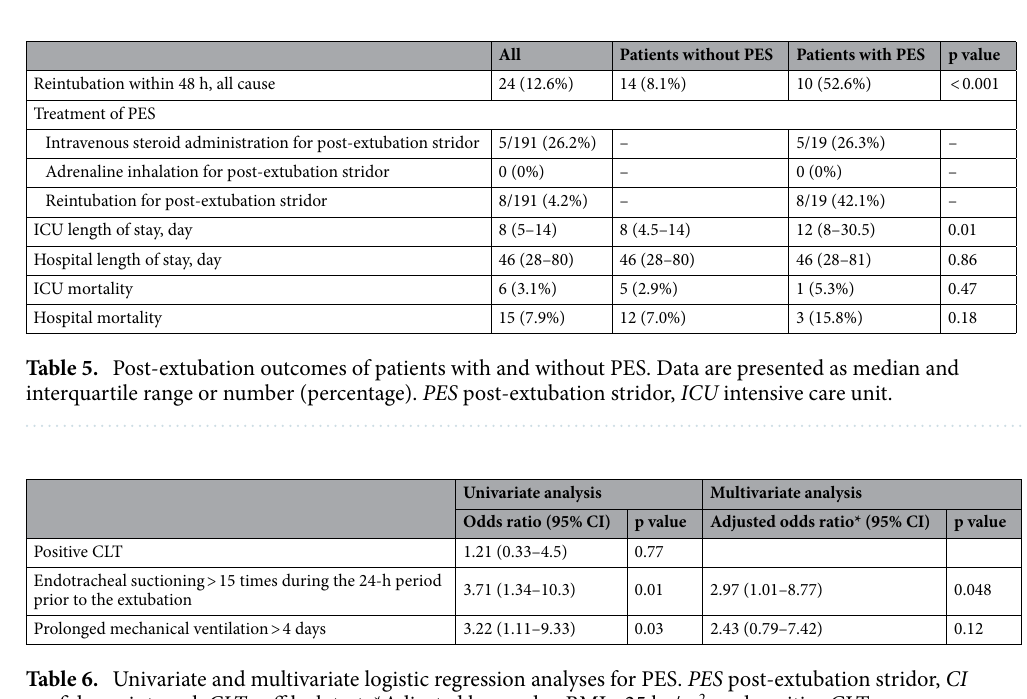
All Patients without PES Patients with PES p value